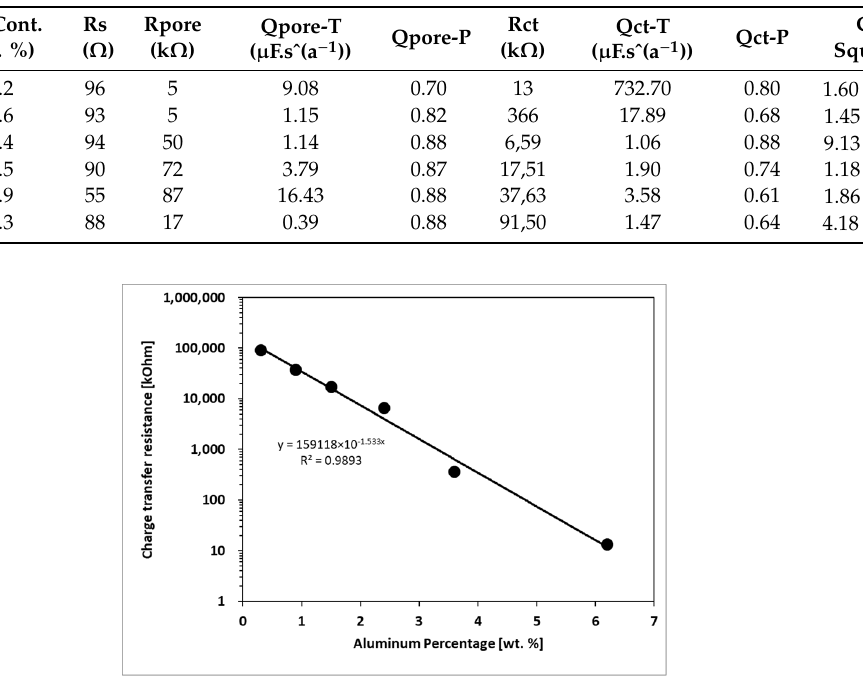
Figure 7. The charge transfer resistance (Rct) extracted from fitting the EIS curves vs. Al content.